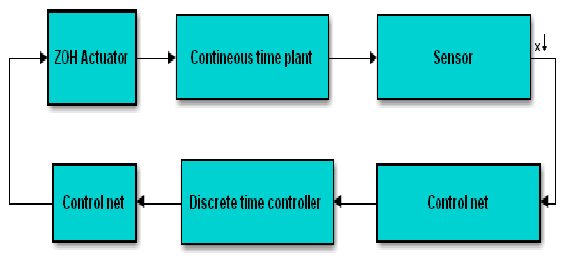
Fig. 8. Block diagram of